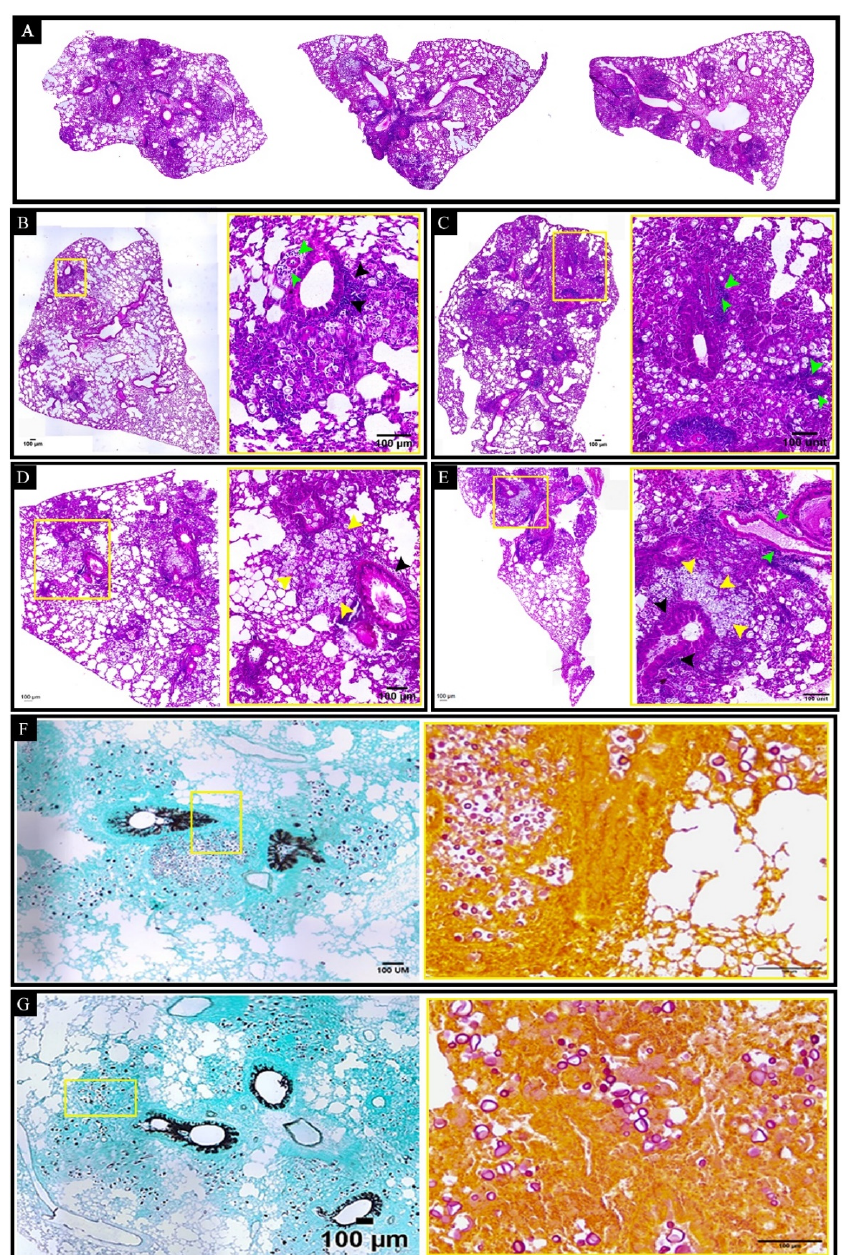
Figure 7. Histopathological analysis of the lungs of BALB/c mice treated with curdlan and immunized with HK- C. gattii . ( A ) The panels show representative lung sections from untreated mice (left side) or those that were immunized with HK- C. gattii in the presence (right size) or absence (middle size) of curdlan. ( B – E ) The total lung (10× magnification) and lung sections (40× magnification) have been shown for each panel. The sections were stained with hematoxylin and eosin (H&E). Perivasculitis (green arrows) and peribrochiolitis (black arrows) were observed, with exudates primarily composed of mononuclear leukocytes. Inflammatory infiltrate composed of mononuclear leukocytes and neutrophils filling the alveolar space contained oval to rounded (yellow arrows) yeast cells diffusely distributed or restricted to the vacuolated cytoplasm of macrophages. The nodules consisted of high concentrations of aggregated C. gattii yeasts (yellow arrows). ( F , G ) The panels show representative lung sections for the different groups. The sections were stained with Grocott (left side, 10 × magnification) and Mucicarmin (right side; 20 × magnification) stains to visualize the distribution of fungi. The images presented are representative fields of the different groups. Five mice were analyzed per group. Magnification bar: 100 µ